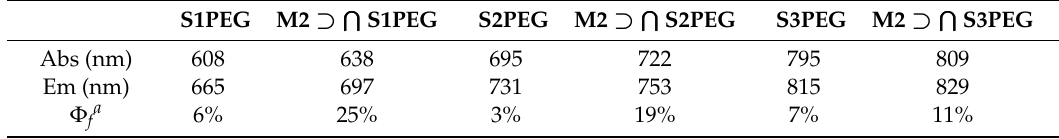
Table 2. Photophysical properties of squaraines and their complexes with M2 in H 2 O.